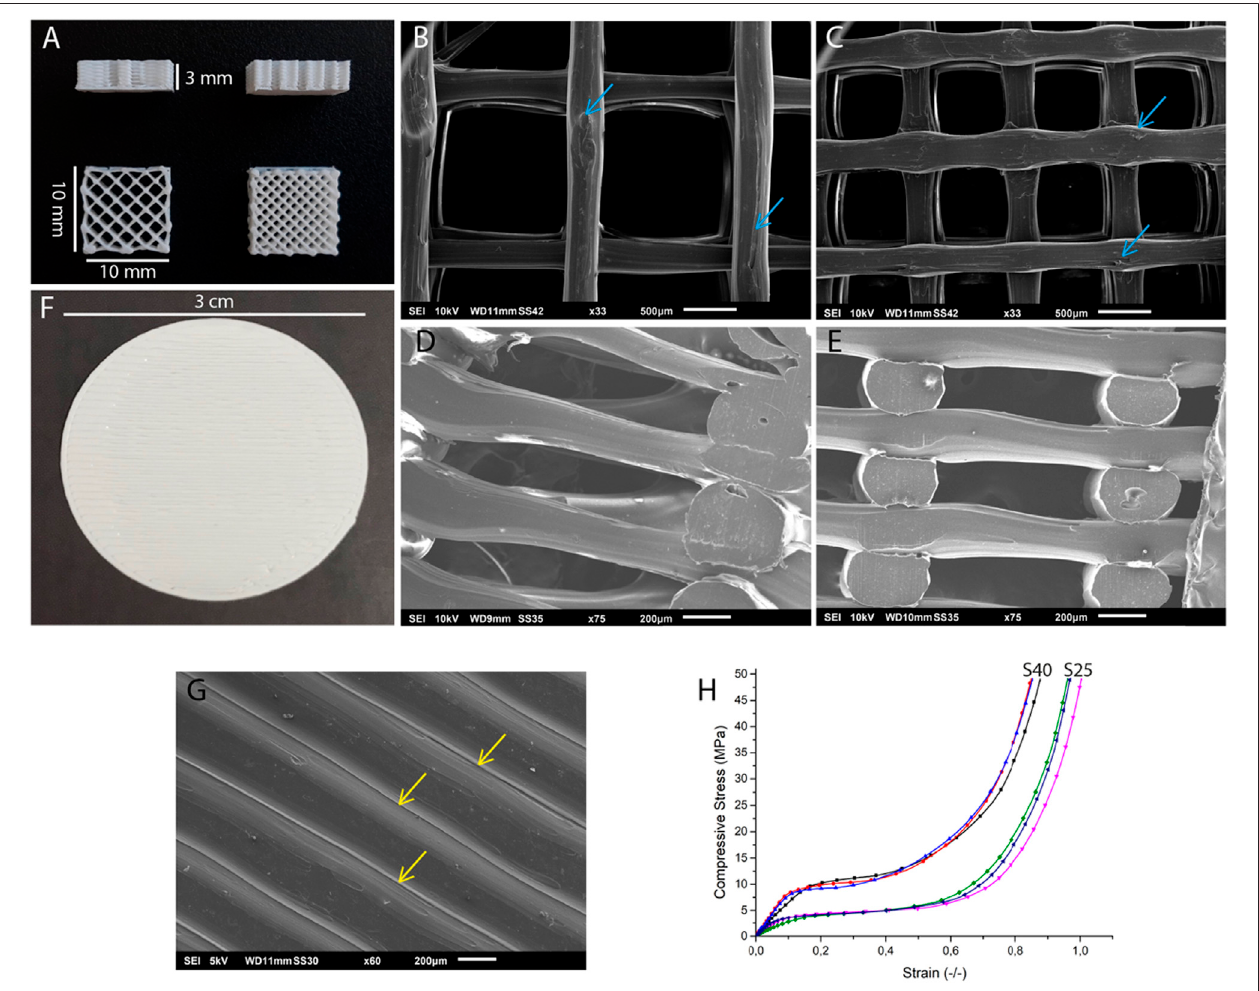
FIGURE1| Structural and mechanical characterizationofthe3D printed PLA scaffolds. (A) Sideview ofthe3D scaffold and top views oftheS25 (left)and the S40 (right).SEMimagesofthe (B) surfaceoftheS25, (C) S40, (D) internalstructureoftheS25and (E) S40.Thebluearrowsindicatetheroughareasonthescaffolds. (F) PLA disc. (G) SEM image of the surface of the PLA disc. Yellow arrows indicate the PLA fi laments forming the ruf fl ed surface of the disc. (H) Mechanical testing of the PLA scaffolds. Young modulus was calculated as the slope of the linear portion of the compressive/strain